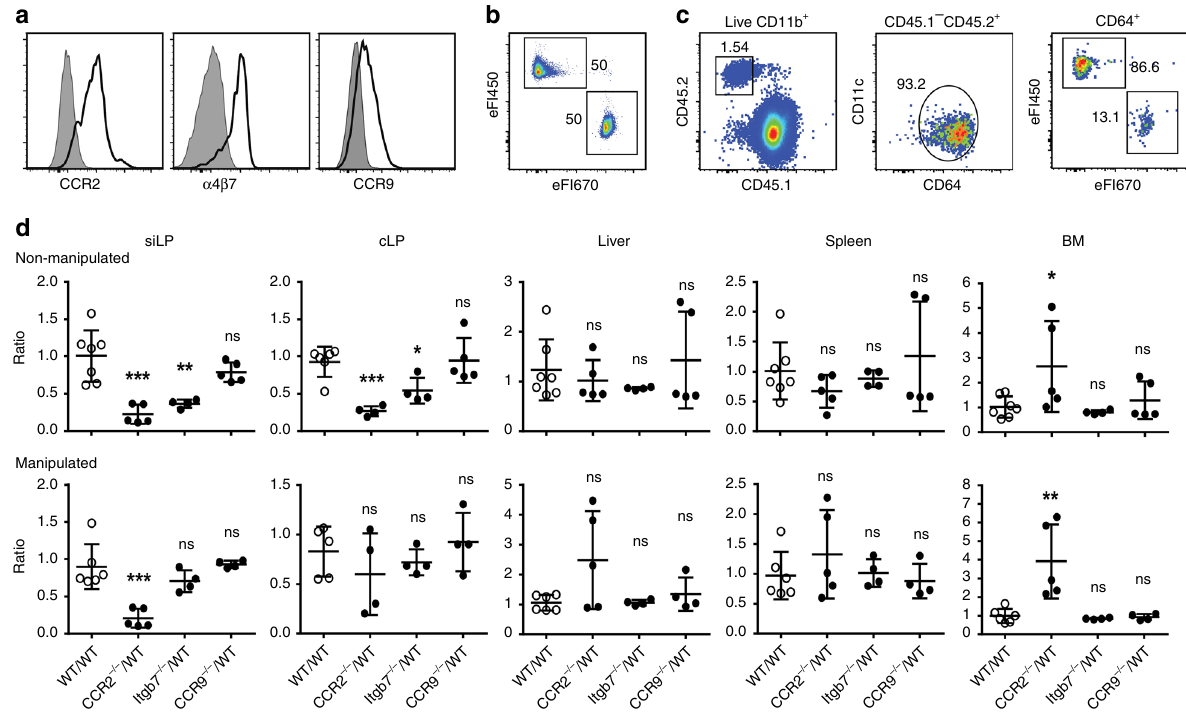
Fig. 2 CCR2, but not β 7-integrin, mediates homing of circulating monocytes to the in fl amed intestine. a Puri fi ed CD11b + Ly6C + BM monocytes express CCR2, α 4 β 7-integrin, and CCR9. Isotype controls are shown as gray shaded histogram. b Monocytes were puri fi ed from BM of CD45.2 + WT and gene- de fi cient donors (CCR2, β 7-integrin, or CCR9), differentially labeled with either eFluor 450 or eFluor 670 and mixed at a 1:1 ratio. c Mixtures of labeled monocytes were transferred into non-manipulated and manipulated CD45.1 + CCR2 -/- recipients. Transferred cells were identi fi ed by congenic markers (left panel) and the donor monocytes identi fi ed as CD11b + CD11c low/int CD64 + cells (middle panel). The frequency of the differentially labeled donor monocytes (right panel) was analyzed one day after cell transfer to determine the ratio of gene-de fi cient to WT cells. d In small intestinal lamina propria (siLP), colonic lamina propria (cLP), liver, spleen, and BM, the ratio of gene-de fi cient to WT monocytes was determined 1 day after cell transfer as indicated in c . Data are displayed as relative change with respect to control experiments comparing differentially labeled WT monocytes. Data were pooled from two or more independent experiments. Symbols depict individual mice, n = 4 – 7 mice. One-way ANOVA followed by Sidak ’ s multiple comparison tests; mean ± s.d.; ns not signi fi cant; * p < 0.05, ** p < 0.01, *** p <